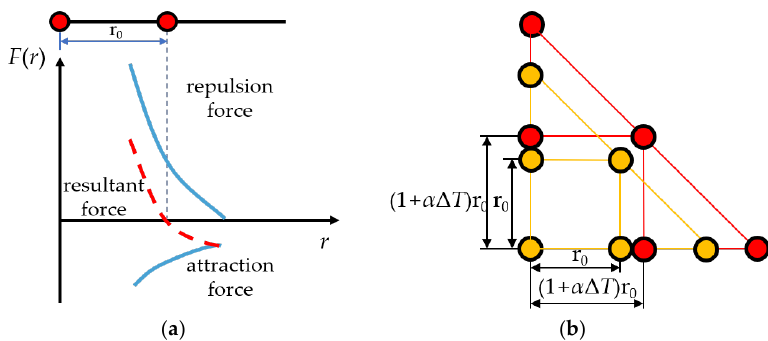
Figure 1. Schematic diagram of expansion and contraction. ( a ) The principle of expansion and contraction; ( b ) thermal expansion of isotropic materials.